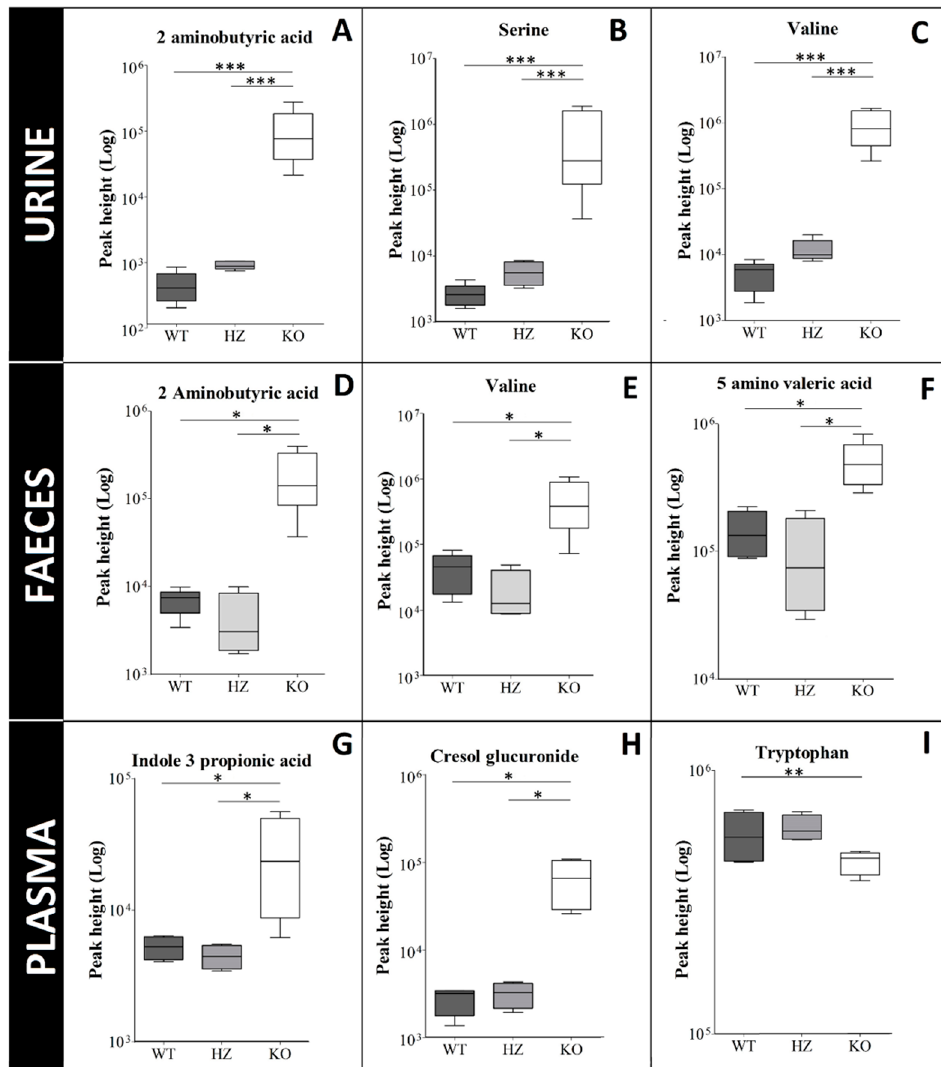
Figure 5. Correlation between SLC6A19 expression and biomarker levels. Box plots of individual biomarkers in SLC6A19 ko, hz and wt samples. Urine metabolites: ( A ) 2-aminobutyric acid, ( B ) serine, ( C ) valine; faecal metabolites: ( D ) 2-aminobutyric acid, ( E ) valine, ( F ) 5-amino valeric acid; plasma samples: ( G ) indole-3-propionic acid, ( H ) cresol glucuronide, ( I ) tryptophan. Horizontal lines represent from bottom to top: the minimum, 25th, 50th, and 75th percentiles and the maximum. Solid line within the boxplot represents median value. Asterisks define the p value; ***: p < 0.001, **: p = 0.001 to 0.01 and *: p = 0.01 to 0.05.